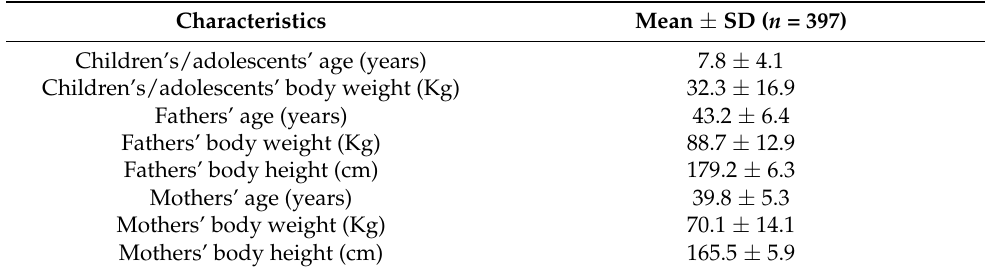
Table 1. Families’ age and anthropometric characteristics. The COV-EAT study.